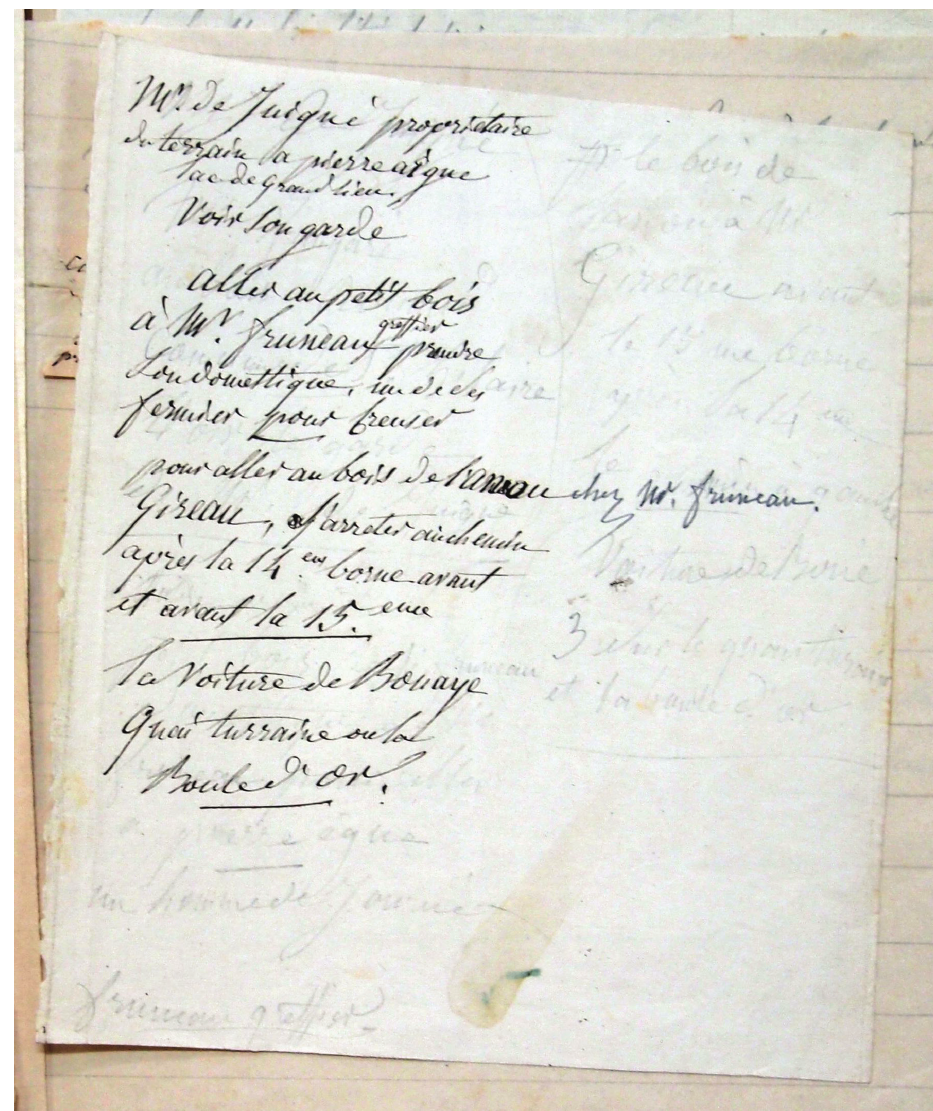
Figure 5: List of contacts near Bouaye. MHNN, 2R842, undated,